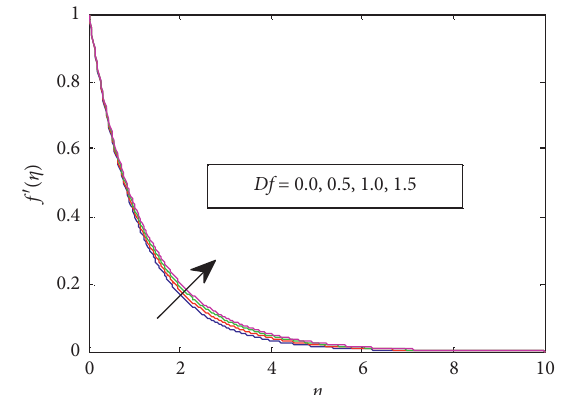
Figure 4: Velocity distribution for different values of Dufour